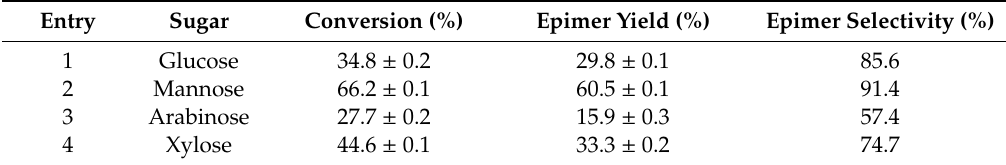
Table 3. Catalytic performance of the catalysts for aldose epimerization.